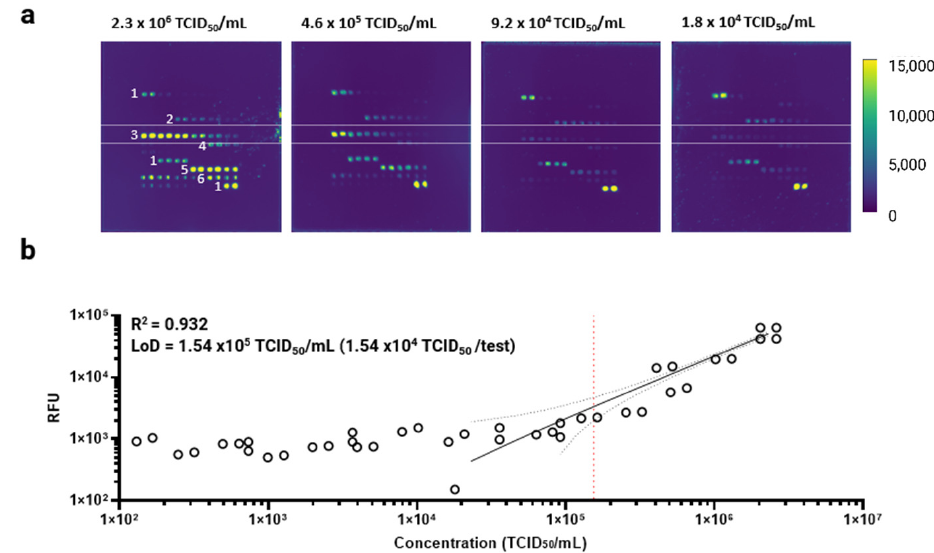
Figure 3. Characterization of the protein microarray against heat-inactivated SARS-CoV-2 culture fluid. Heat-inactivated SARS-CoV-2 sample was serially diluted two-fold and five-fold in two independent titration experiments, respectively. ( a ) Example microarray images representing fluorescence signals developed from different virus titers are shown. The two white lines (label 3) indicate the location of the optimal anti-SARS-CoV-2 NP capture antibody printed at different concentrations. ( b ) Using the highest capture antibody concentration in duplicates, linear regression was performed between the virus titer in TCID 50 /mL and raw RFU. The data were plotted on a log–log scale. The black straight line represents the linear regression line. The red dotted line represents the calculated limit of detection (LoD), which was calculated by multiplying 3.3 by a standard deviation of the y-intercept over the slope. The black dotted line represents the 95% confidence band of the linear regression line.